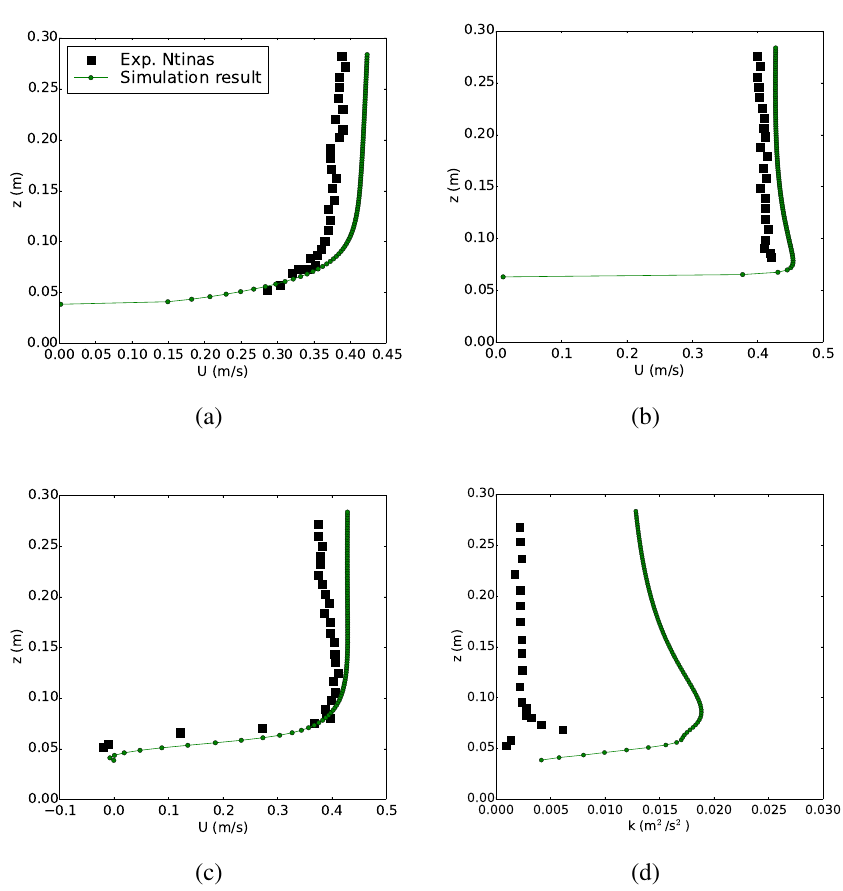
Figure 5. Comparison of U and k at the vertical section at the center of the domain for the validation case. ( a ) U